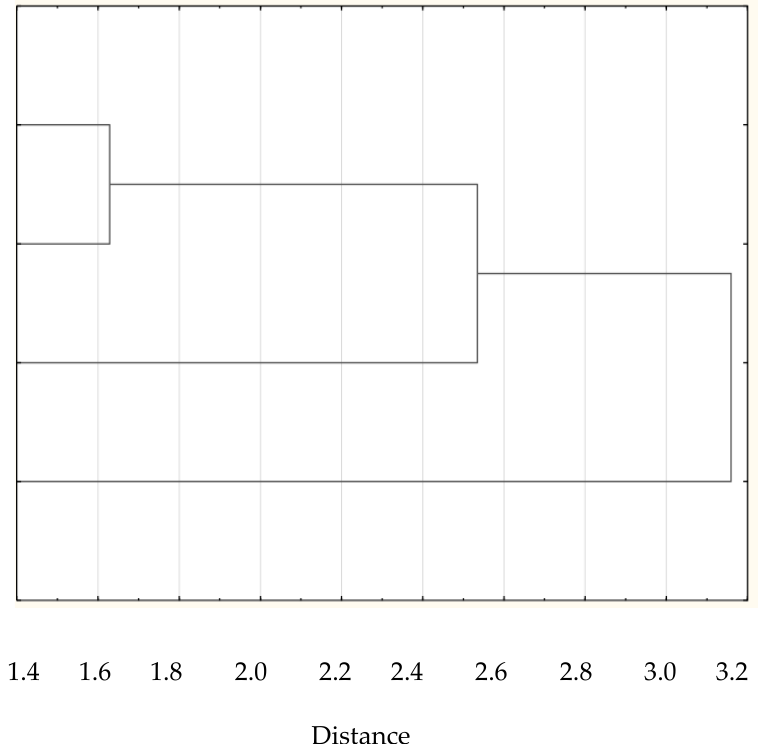
Figure 6. Hierarchical cluster graph of chia seed (extracted, processed and un-processed).